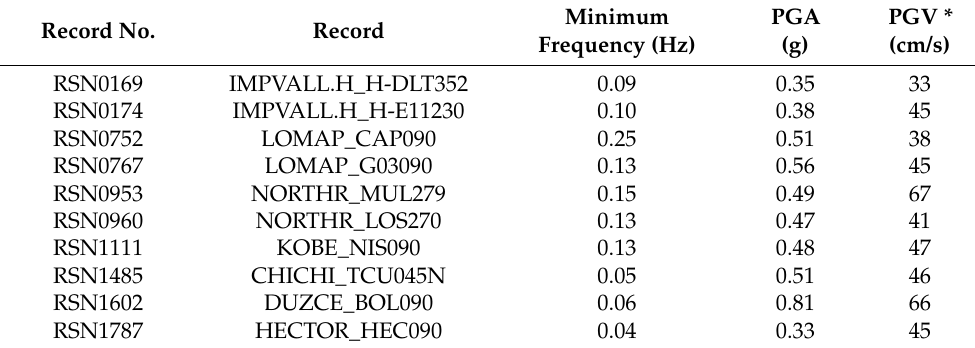
Table 12. Selected Ground